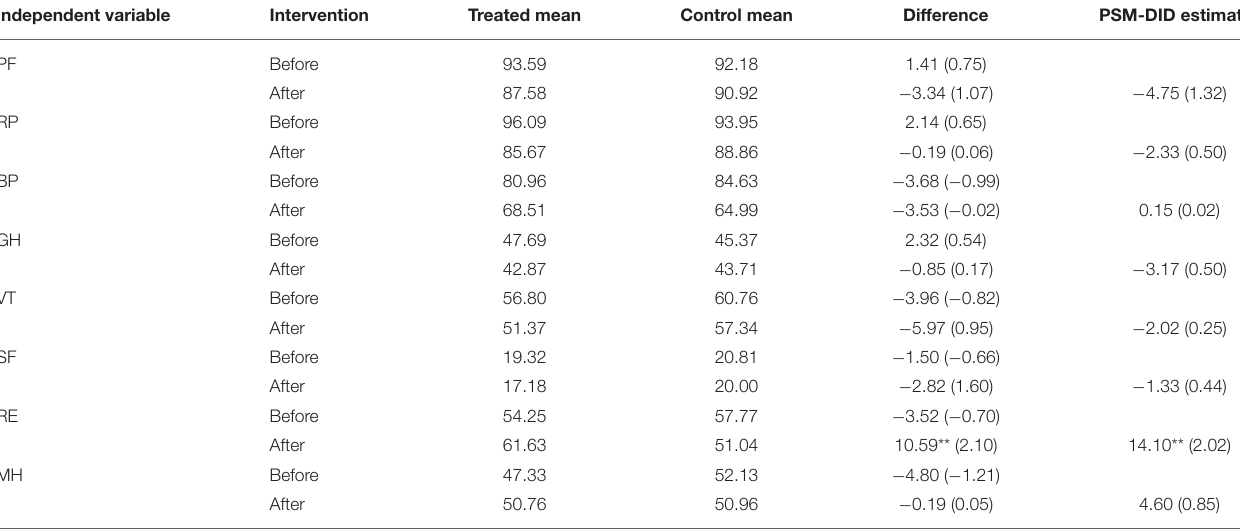
TABLE 3 | Propensity score matching with difference-in-differences (PSM-DID) estimate result. Independent variable Intervention Treated mean